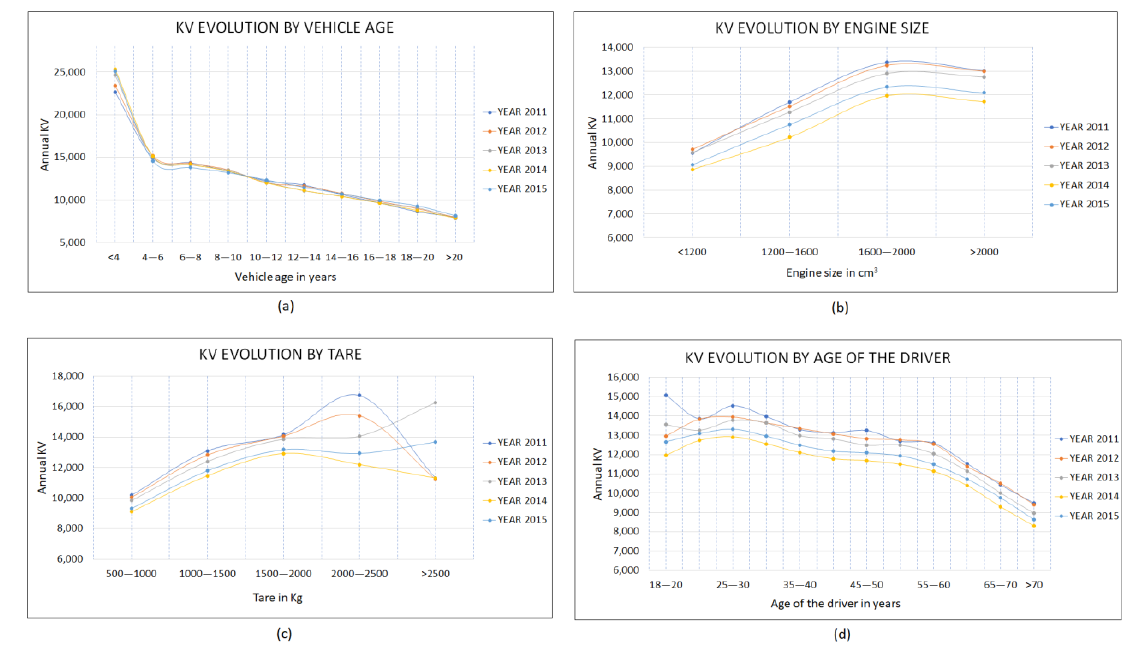
Figure 4. Distribution of kilometers per year by vehicle attribute. ( a ): KV evolution by vehicle age; ( b ): KV evolution by engine size; ( c ) KV evolution by tare; ( d ): KV evolution by age of the driver. At the total vehicle fleet level, a decrease in annual VKT with vehicle age was ob- served. This behavior is similar in the different provinces of Spain. The comparison was